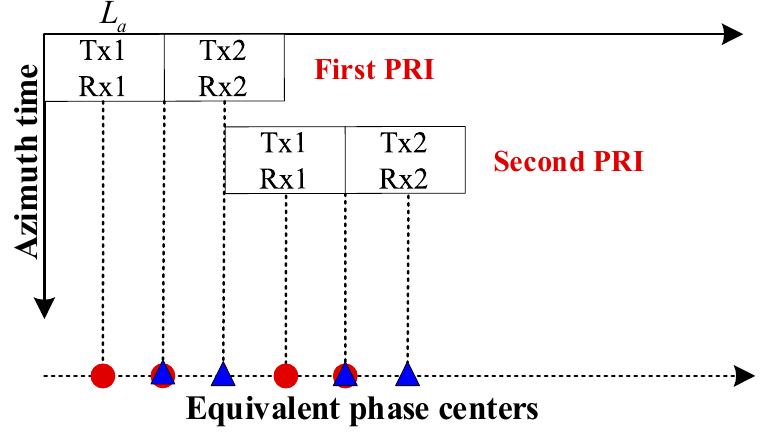
Figure 2. Distribution of the equivalent phase centers in the OAM-based MIMO-SAR system.